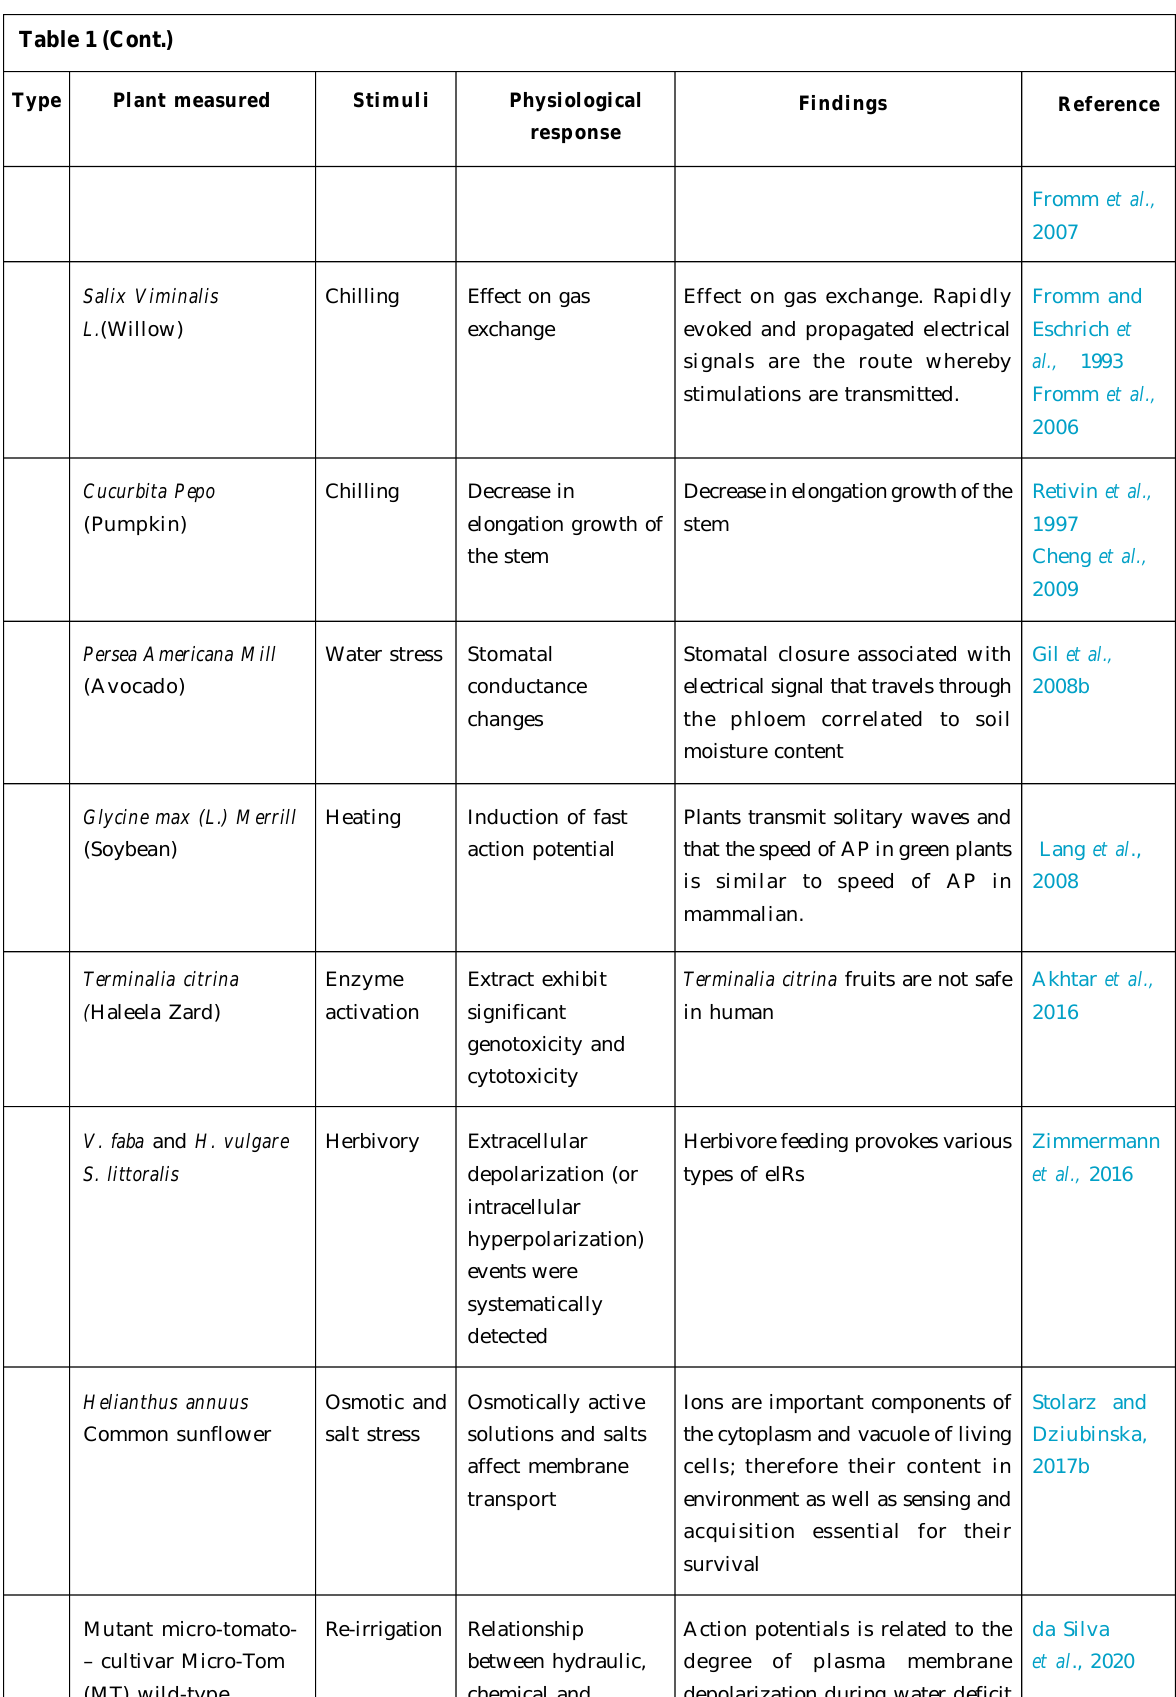
Table 1 (Cont.) Plant measured Stimuli Physiological